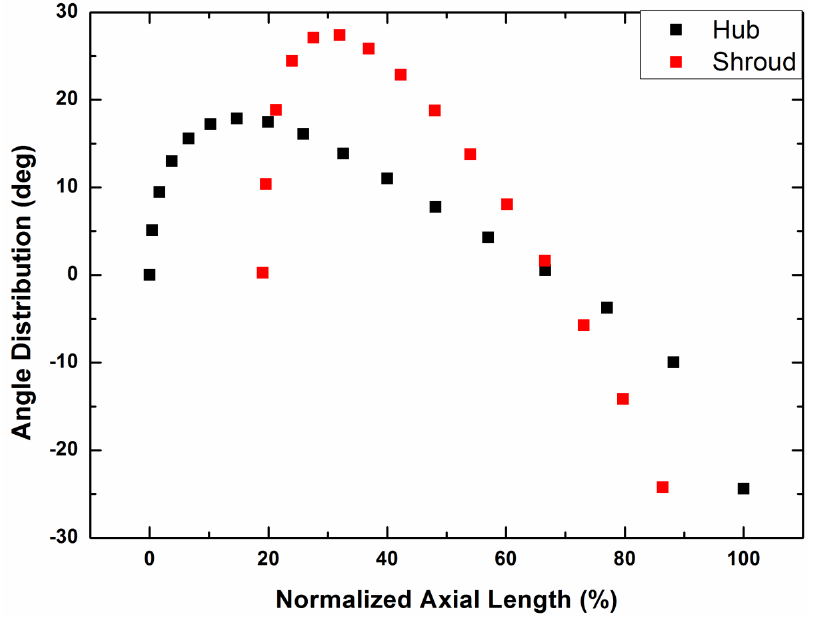
Table 3. Definitions of blade thickness coefficients.